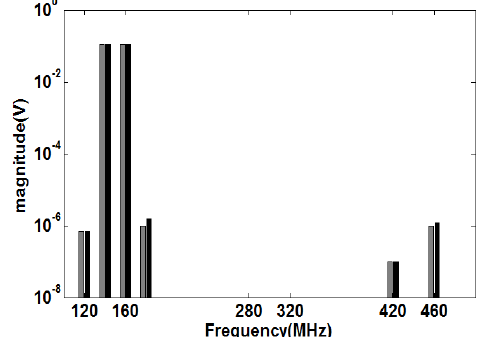
TABLE I. Run time (sec) of HB and NC techniques for infinite collinear array of nonlinear antennas.